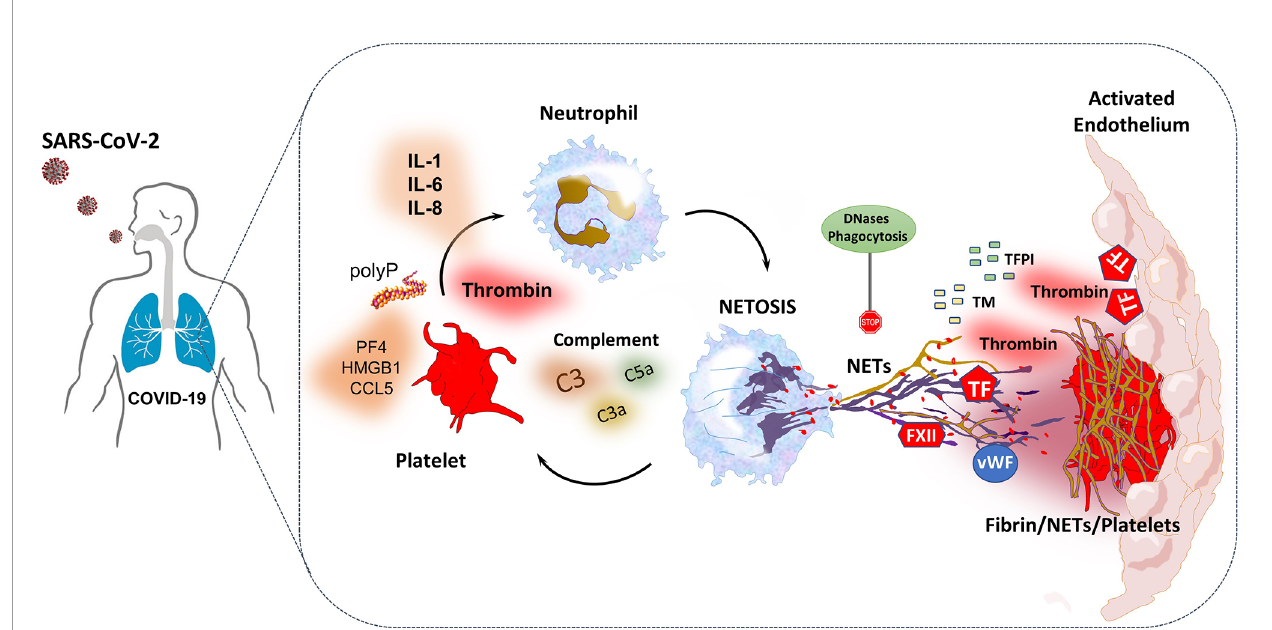
FIGURE 7 | SARS-CoV-2-triggered NETs induce thromboin fl ammation through interactions with complement system, platelets and the coagulation cascade (161, 163). NETs provide a platform for expression-activation of coagulation factors such as TF and FXII. They also interact with vWF released by endothelial cells and platelets, leading to platelet adhesion and fi brin formation (174). Additionally, NET-derived histones and TF can induce endothelial cell activation and thrombogenicity. Furthermore, NET formation also enhances thrombus stability and lytic resistance, while through the release of neutrophil elastase, degrades TFPI and thrombomodulin and thus dampens anticoagulation (174). Probably, in COVID-19, increased levels of platelet-derived thrombin and factors such as polyphosphate (polyP), high mobility group box 1 (HMGB1), PF4, RANTES, as well as complement and IL-1, IL-6 and IL-8 can trigger NETosis, which in turn activates platelets creating a feedback loop (174, 175). To the contrary, excessive NET formation is homeostatically regulated by anti-in fl ammatory mechanisms such as NET degradation by DNases, and phagocytic removal by macrophages, thus NET levels may normalize in convalescent patients (163, 174, 176). All the above suggest that the interplay between complement, platelets and NETs may play a central role in the immunothrombosis and ARDS observed in COVID-19 (161, 163, 176). ARDS, acute respiratory distress syndrome; FXII, coagulation factor XII; IL, interleukin; NET, neutrophil extracellular trap; PF4, platelet factor 4; RANTES, Regulated upon Activation, Normal T Cell Expressed and Presumably Secreted; TF, tissue factor; TFPI, tissue factor pathway inhibitor; vWF, von Willebrand